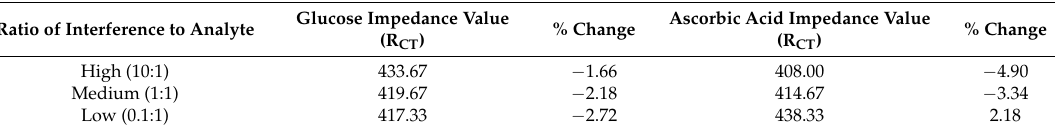
Table 1. Interference study on the Hb/TiAu-APTS/SPE biosensor towards glucose and ascorbic acid with 1 mM H 2 O 2 at different ratios ( n = 3).